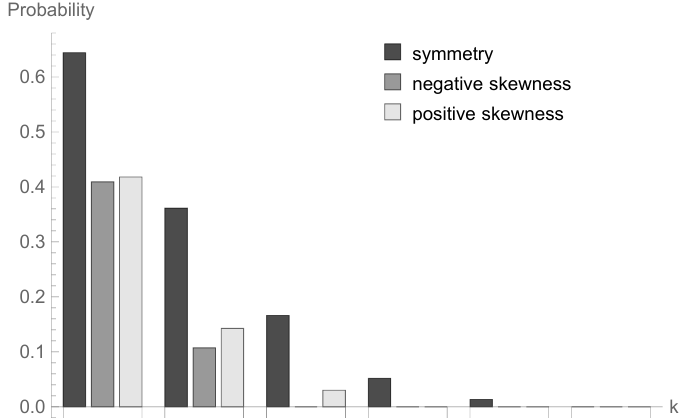
Figure 10. Impact of skewness type on conditional probabilities (cid:98) ∆ 3 ( k ) for bounded discrete processing distribution and (cid:36) = 1.